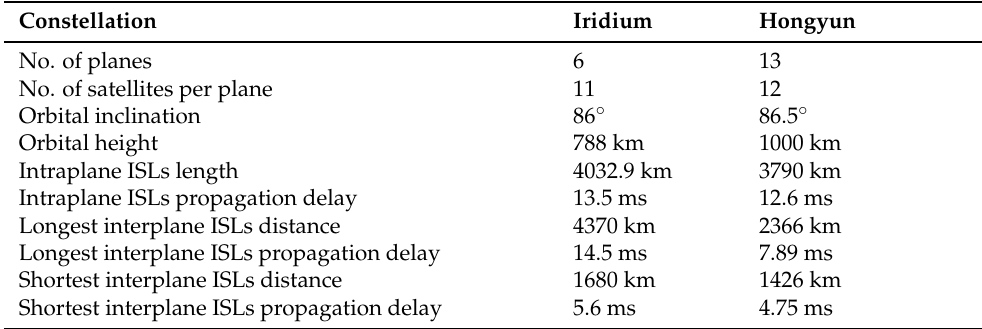
Figure 4. Interplane ISL distance vs. time. Table 3. The comparison between